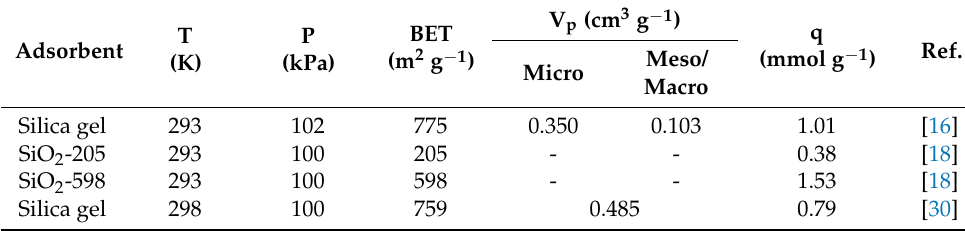
Table 2. N 2 O adsorption in silica-based